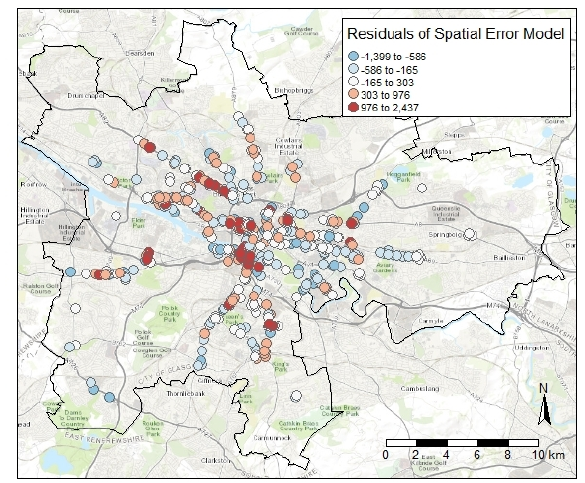
Figure 7 . Spatial distribution of residuals of the spatial error